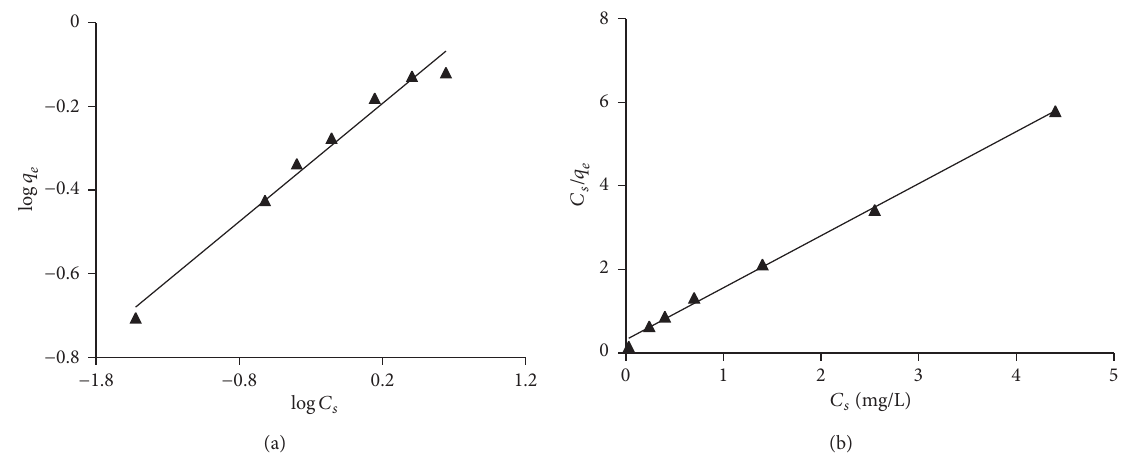
F 6: e Freundlich and Langmuir isotherms for �uoride adsorption using MIAA at (20